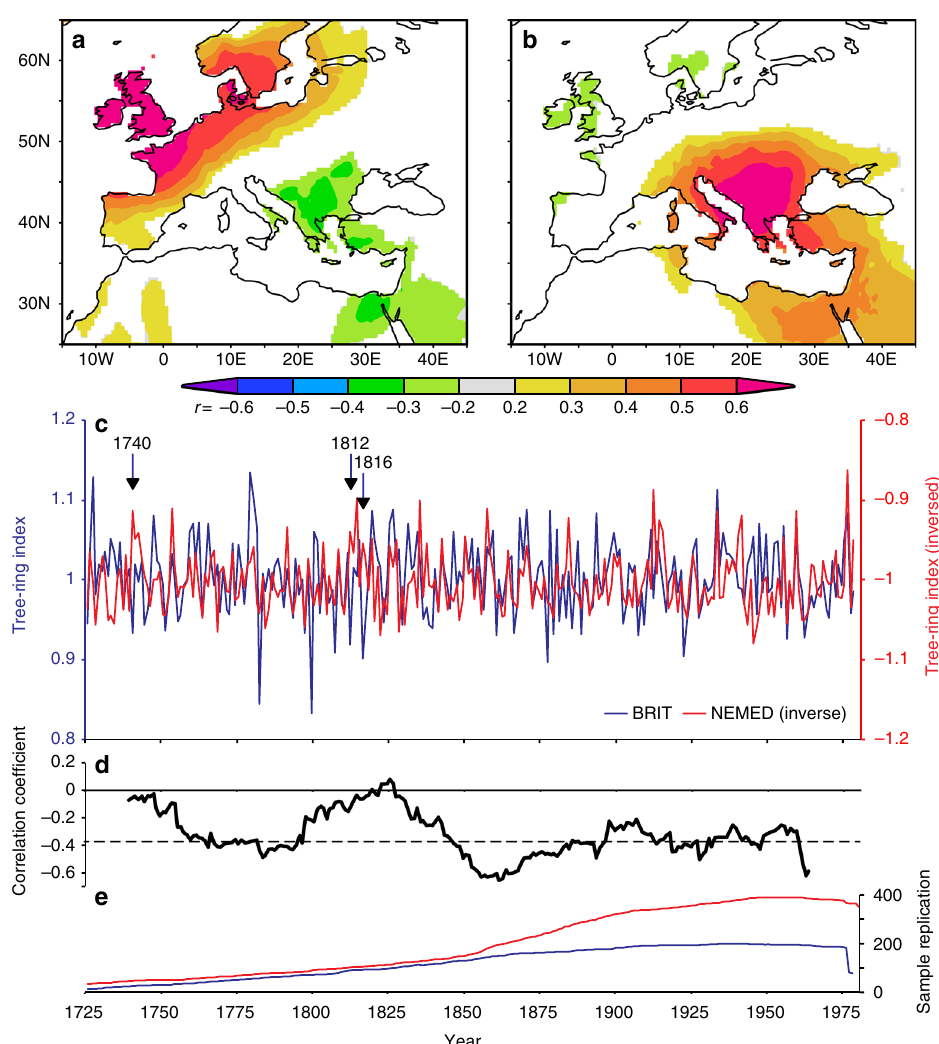
Fig. 2 BRIT and NEMED tree-ring chronologies. a , b Pearson's correlation maps of BRIT ( a ) and NEMED ( b ) tree-ring chronologies with gridded 1° CRU TS4.0 47 August temperature anomaly fi elds (1901 – 1978) over Europe. Correlation coef fi cients higher than 0.3 are signi fi cant at the p < 0.01 signi fi cance level. c BRIT and NEMED (inversed) tree-ring chronologies (1725 – 1978) and d their sample replication over time. e The 31-year running Pearson's correlation coef fi cients between the BRIT and NEMED chronologies are consistently negative over the full period, except for years (1740, 1812, 1816) when external forcings created cold conditions throughout Europe. Correlation coef fi cients below − 0.374 (dashed line) are signi fi cant at the p < 0.05 level. Correlation maps in a , b were created in the KNMI Climate Explorer